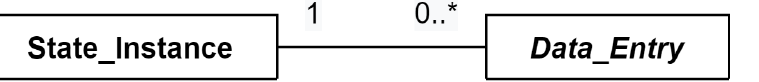
Figure 7. Each state instance can hold data entries provided by the system (component).